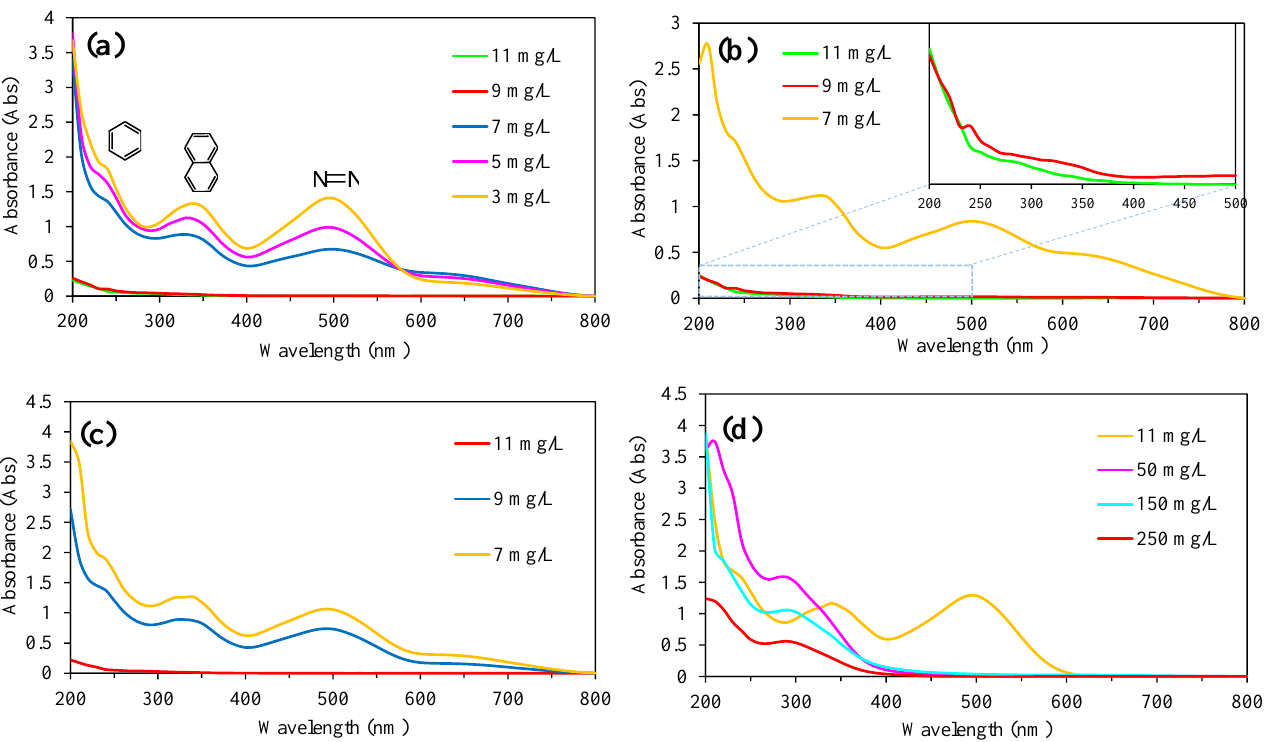
Figure 3. UV–Vis spectra analysis of diazo Congo red dye after treatment with different dosages of PFSS at: ( a ) pH 5; ( b ) pH 7; ( c ) pH 9; ( d ) pH 11.